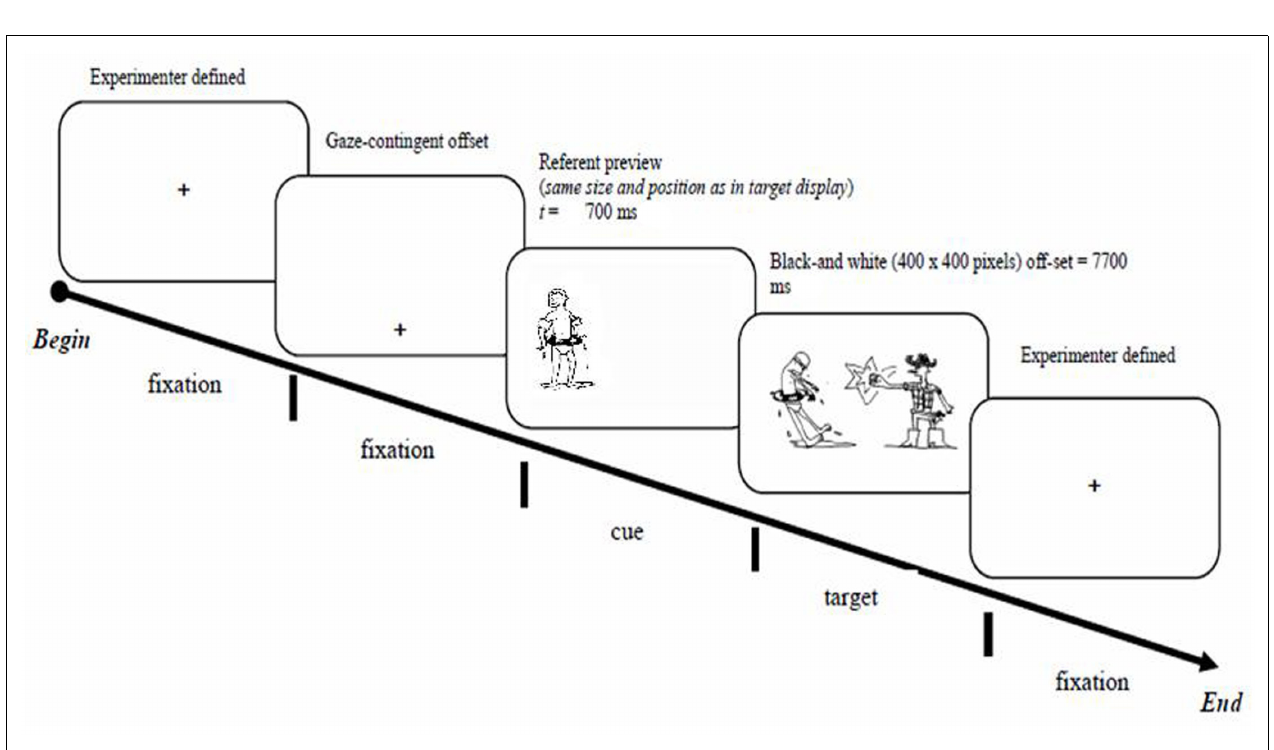
presented target display. Hence, Dot Cues only provided location information whereas Referent Cues provided both location and referential information. Cue duration was 700 ms regardless of